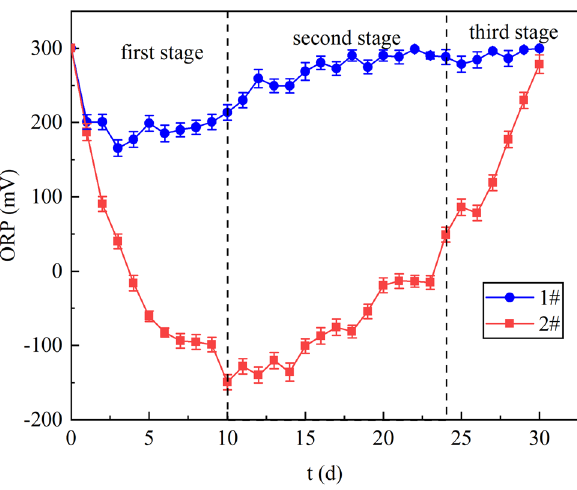
Figure 2. Changes of ORP values in dynamic columns 1# and